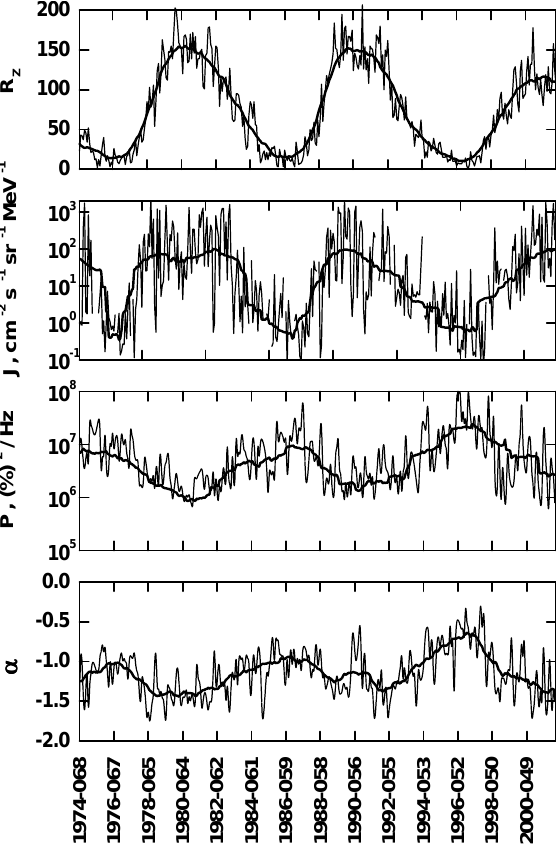
Fig. 1. Time profiles of the sunspot number R z , particle flux J , CR fluctuation power level P and the PSD spectral index α for IMP- 8/CPME (channel P11) data. All data are 27-day averaged. Solid lines depict the corresponding 2-year running means. Time is given in year-DOY.